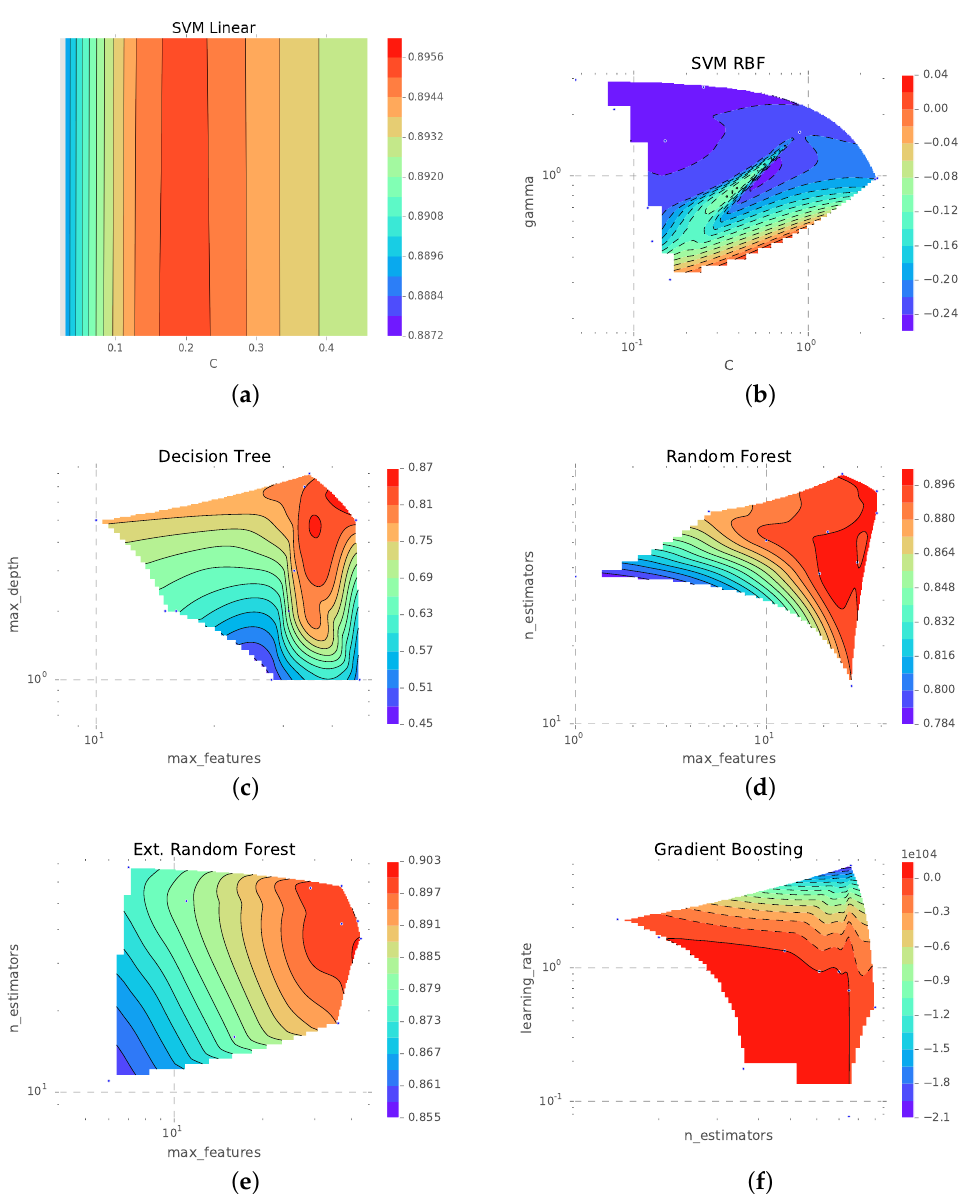
Figure 7. Projection of the parameter hyper-space to the two most significant dimensions. The figures are color-coded based on the average R 2 score of the cross-validation. Red areas are those where error is minimum. ( a ) Support Vector Machine (SVM) linear; ( b ) SVM with Radial Basis Function (RBF); ( c ) Decision Tree (DT); ( d ) Random Forest (RF); ( e ) Extremely RF (ERF); ( f ) Gradient Tree Boosting